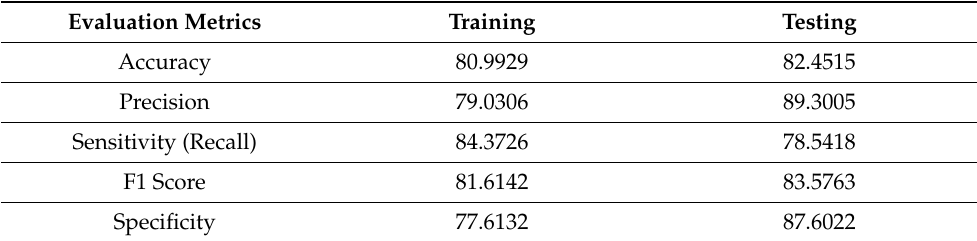
Table 1. Evaluation metrics